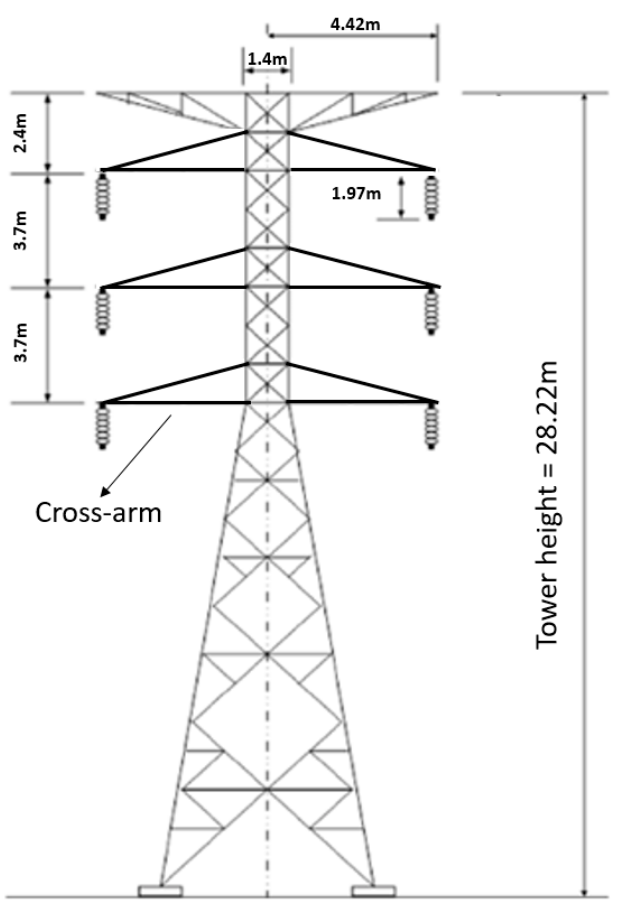
Figure 3. Dimension of latticed transmission tower. Adapted with permission from IEEE, 2021 [33]